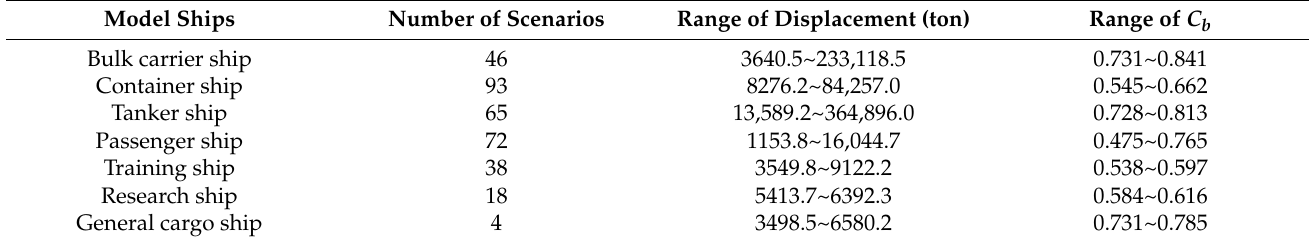
Table 2. Loading